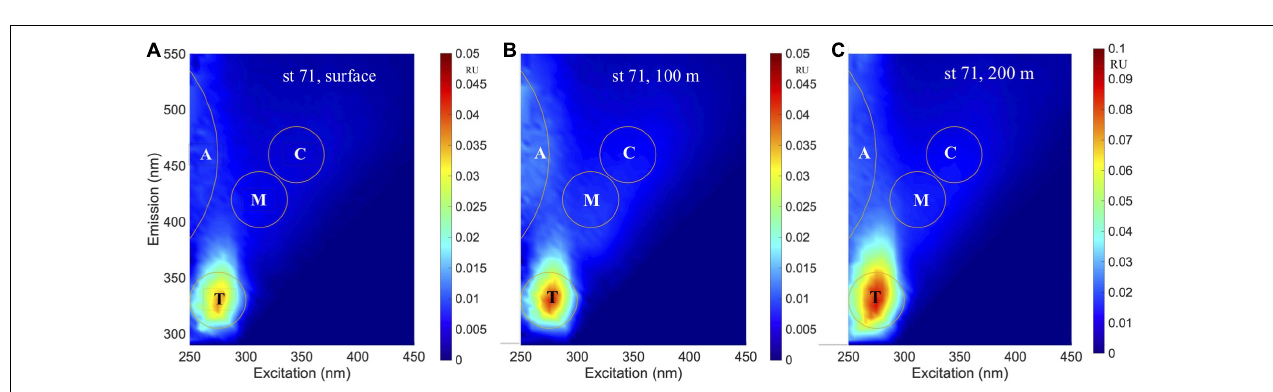
FIGURE 6 | Chromophoric dissolved organic matter (CDOM) relationships. Relationships between (A) salinity, (B) chlorophyll and (C) DOC and a cdom 325; (D) a cdom 325 vs S 275 - 295